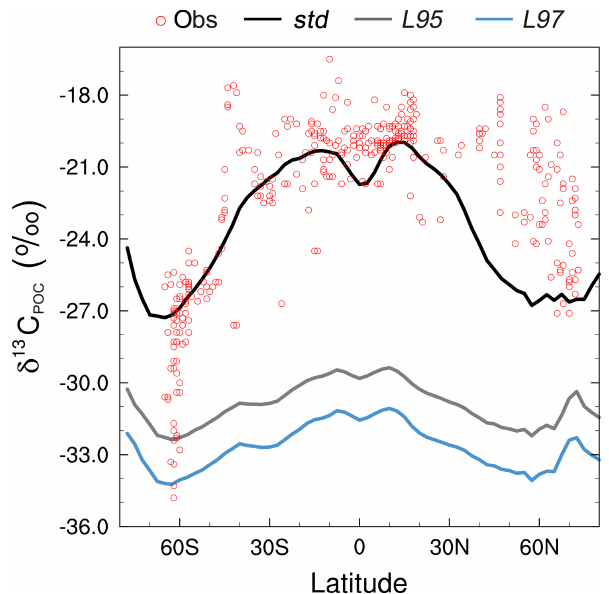
Figure 8. Zonally averaged mean annual mixed layer δ 13 C POC dur- ing the 1990s: observations (Goericke and Fry, 1994; red), the std simulation (black), the L95 simulation (grey), and the L97 simula- tion